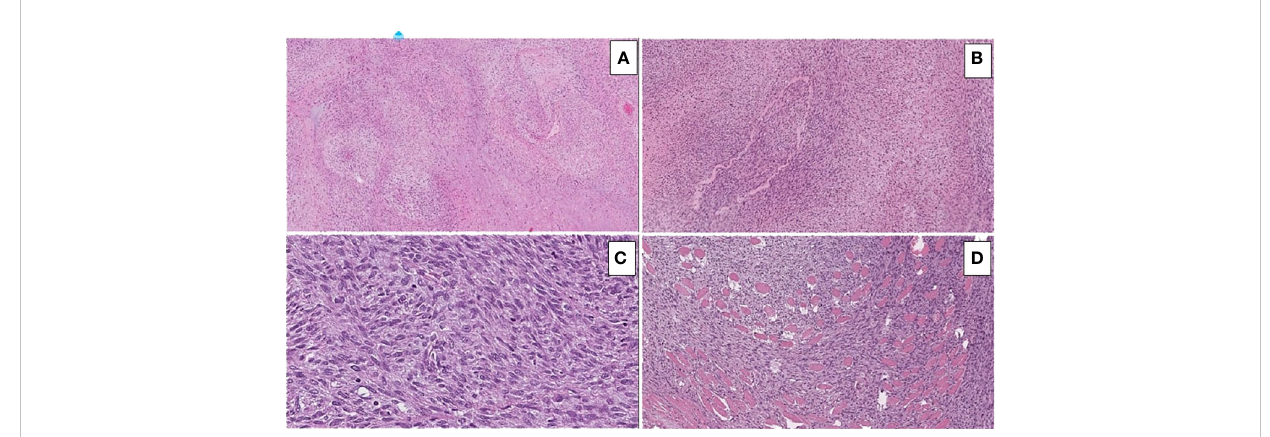
FIGURE 3 Hematoxylin and eosin-stained sections illustrating the main morphological fi ndings: (A) On low power (10x magni fi cation), classic marbled appearance due to alternating hypocellular and hypercellular areas with perivascular distribution of neoplastic cells is seen. (B) Hypercellular areas of the neoplasm consisting of uniform spindle cells with hyperchromatic, thin, and wavy nuclei are visible. (C) Nuclear atypia and numerous mitotic fi gures are easily identi fi able. (D) In fi ltration of the surrounding skeletal muscle is seen.